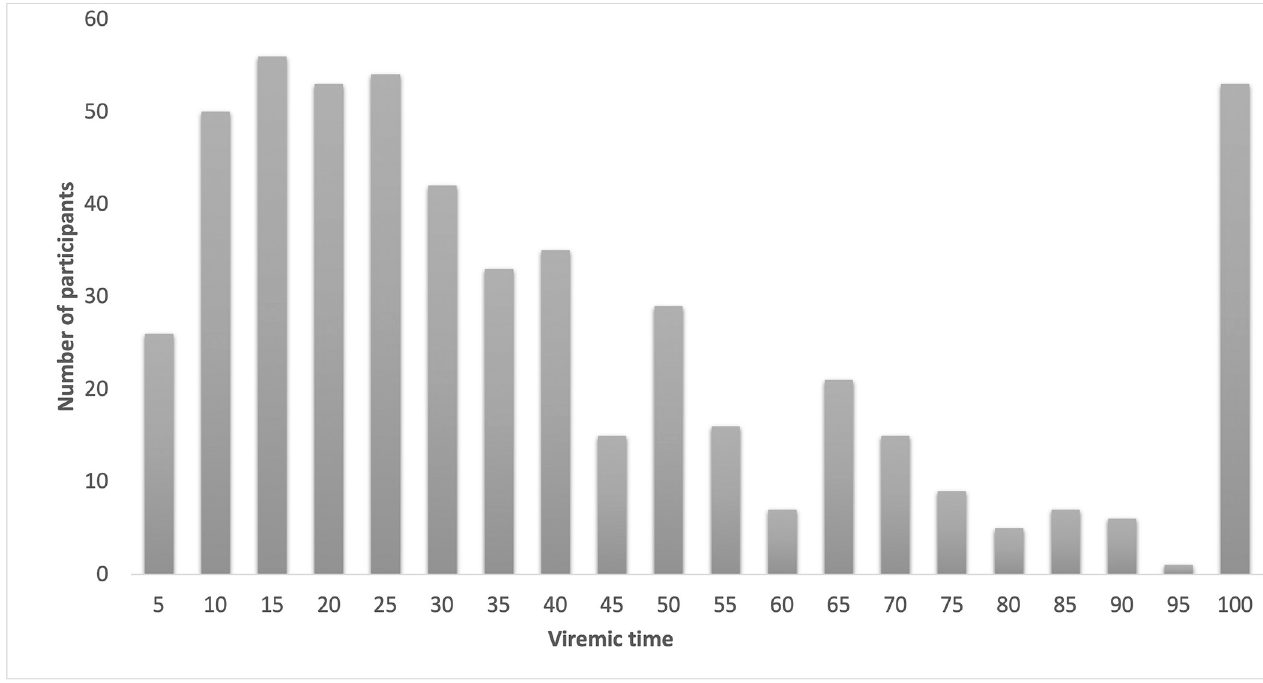
Fig 3. Distribution of participants by viraemic-time among those who experienced viraemia (N = 537).